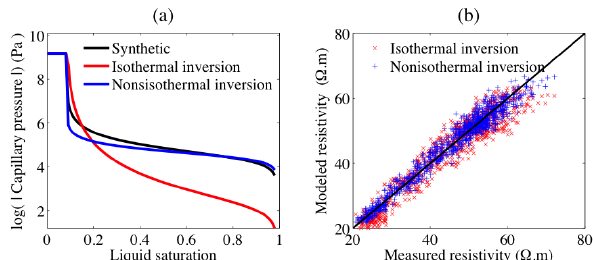
Figure 10. (a) Comparison of the synthetic and estimated van Genuchten’s retention curve. (b) Comparison of synthetic and modeled apparent-resistivity data. The red color represents the re- sults obtained by the isothermal hydrogeophysical inversion scenar- ios. The blue color denotes the nonisothermal